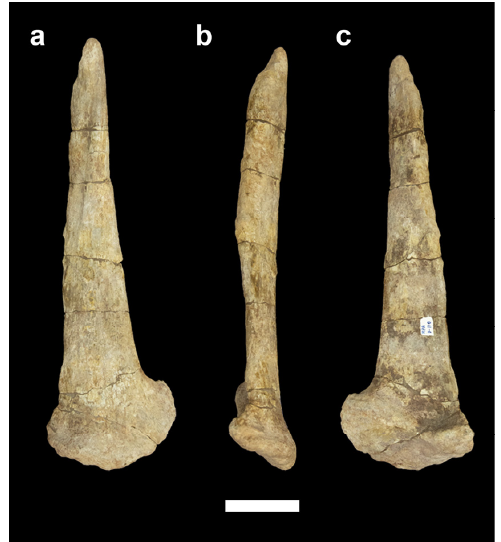
Figure 3. MPA D-110. Dermal spine from Puntal de la Magdalena fossil site (Alpuente, Valencia, Spain) in lateral ( a ), anterior ( b ) and medial ( c ) views. Scale bar = 5 cm.